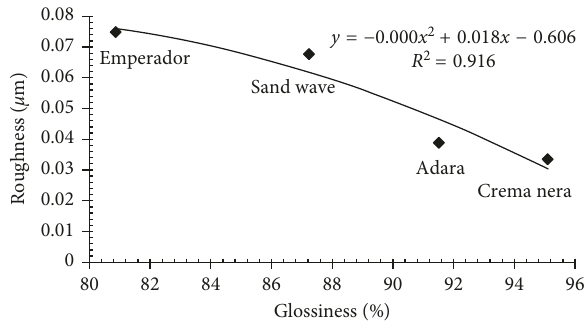
Figure 4: Roughness versus